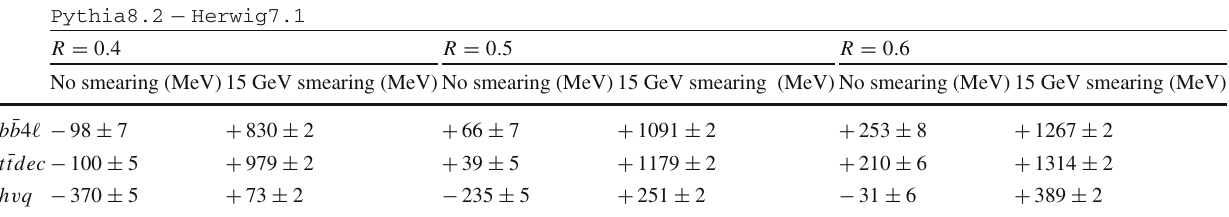
Table 10 Differences in the m Wb peak position obtained matching the three generators with Pythia8.2 and Herwig7.1 , for three choices of j the jet radius Pythia8.2 − Herwig7.1 R = 0 . 4 R = 0 . 5 R = 0 .